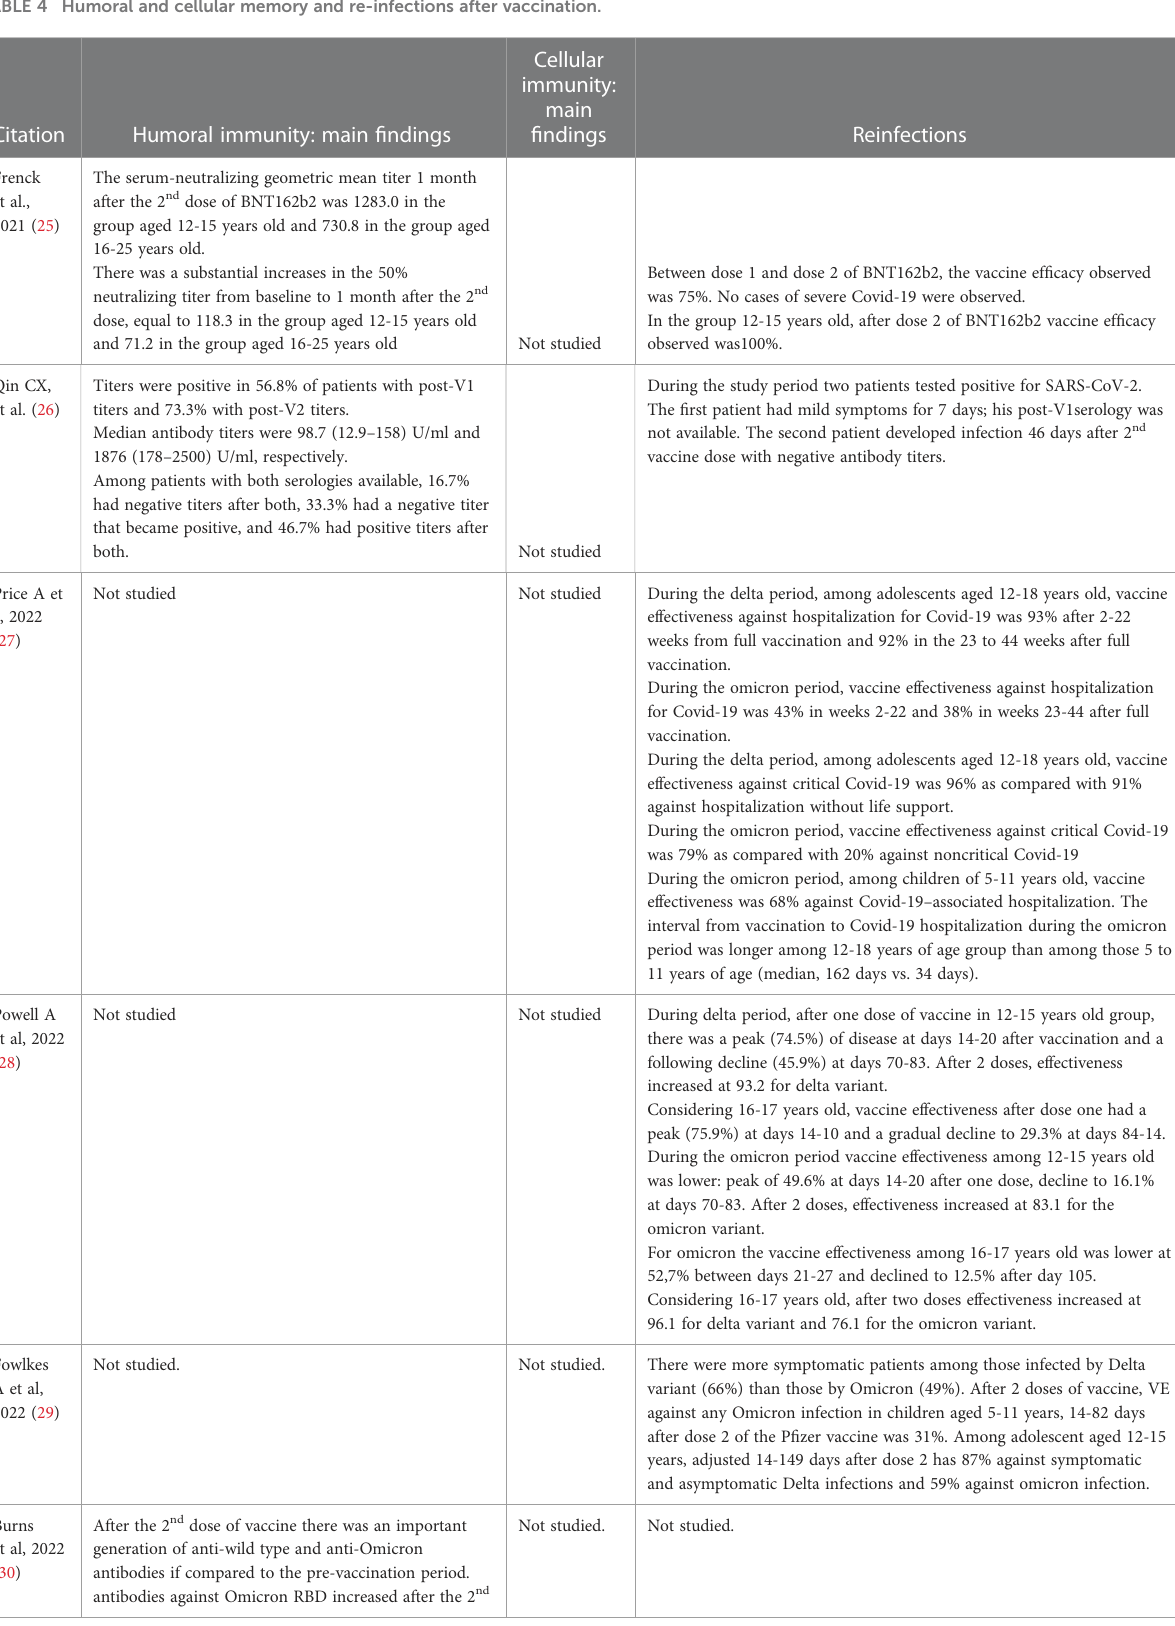
TABLE 4 Humoral and cellular memory and re-infections after